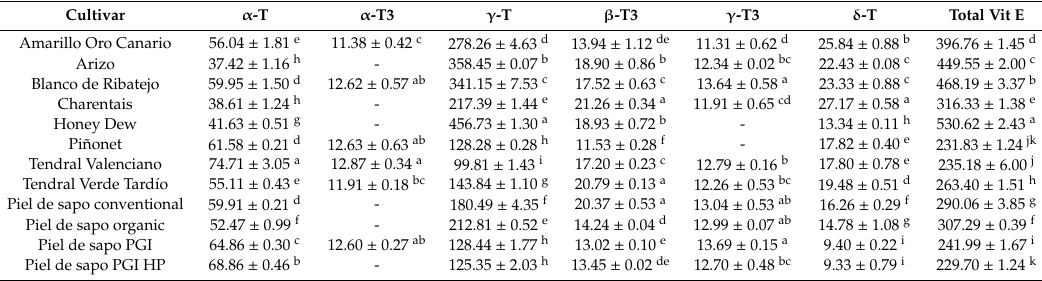
Table 4. Tocopherol and tocotrienol contents (milligrams per kilogram) of studied cultivars. All oils samples were extracted with screw press except the last row, which shows results of tocopherols and tocotrienols of oil from cv. Piel de Sapo (PGI) extracted with hydraulic press. Cultivar α -T α -T3 γ -T β -T3 γ -T3 δ -T Total Vit E Amarillo Oro Canario